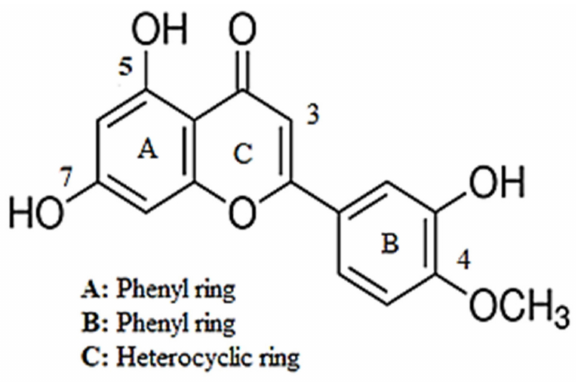
Figure 1. The chemical structure (5, 7, 3 (cid:48) -trihydroxy-4’-methoxyflavone) of